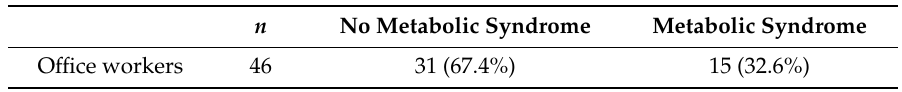
Table 5. Diagnosis metabolic syndrome number (frequency) according to the criteria of the International Diabetes Federation (IDF)